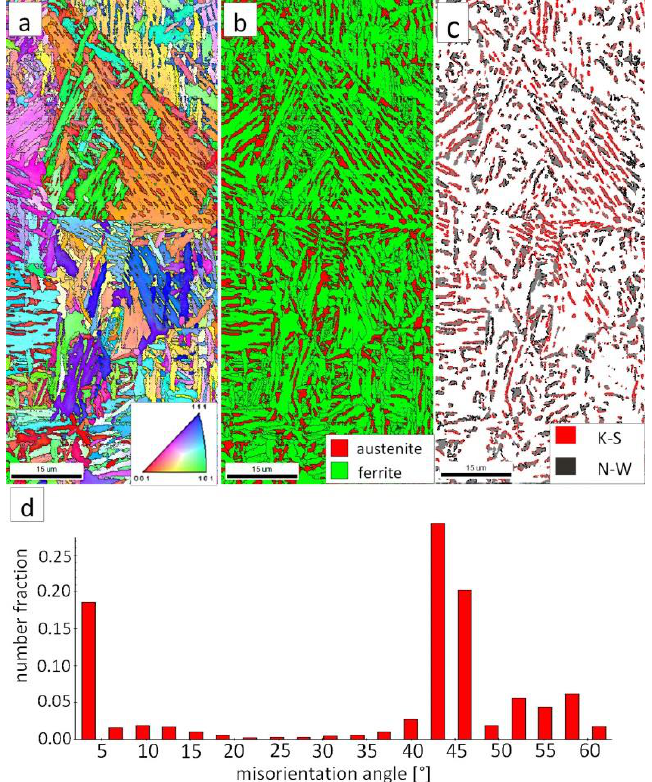
Figure 10. ( a ) IPF Map of the HTHAZ area “B”. ( b ) Phase Distribution Map of the HTHAZ area “B”. ( c ) Phase distribution map with indicated boundaries of N-W (marked in black) and K-S (marked in red) orientations. Ferrite-white, austenite-gray. ( d ) Misorientation angles distribution of the HTHAZ region “B”.